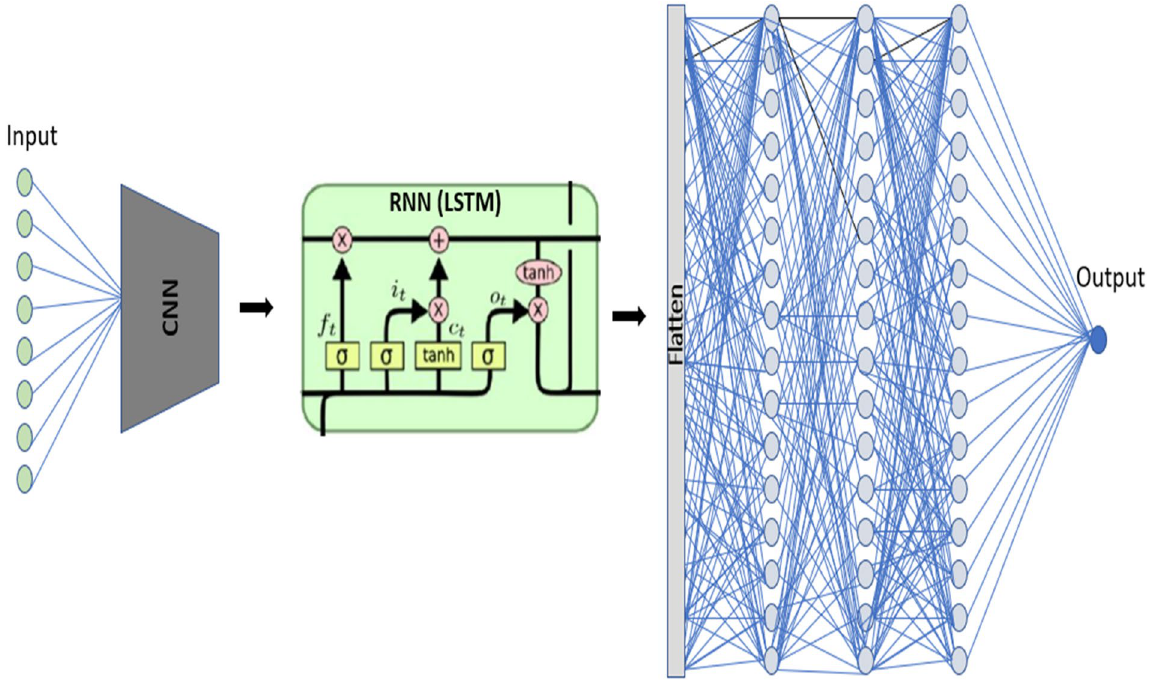
Figure 7. Schematics of the Hybrid CNN-LSTM-ANN